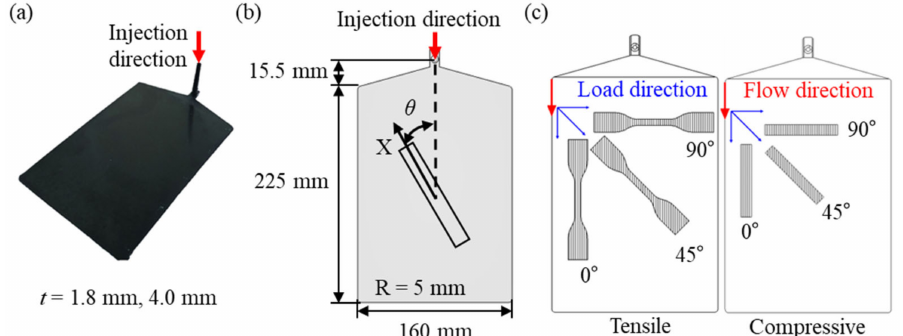
Figure 1. ( a ) PA6-20CF plate manufactured by injection molding, and injection direction, ( b ) Schematic illustration of different fiber orientation ( θ ) specimens obtained from the injection- molded plate (X = loading axis), ( c ) fiber alignment in specimen with fiber orientation ( θ ) = 0 ◦ , 45 ◦ , 90 ◦